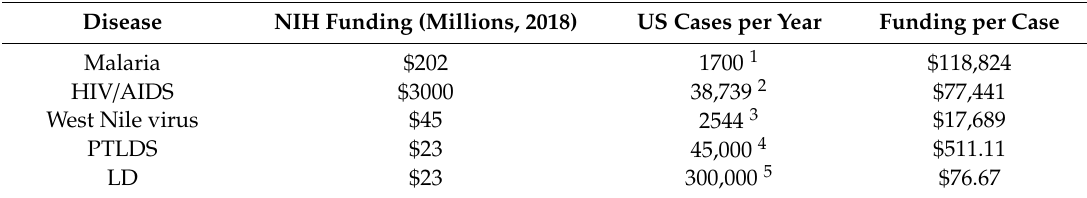
Table 4. In spite of a high annual cost for treatment and significant social costs, NIH funding for LD significantly trails that appropriated for other